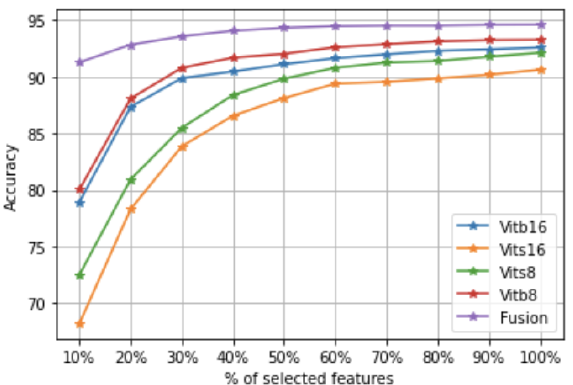
Figure 9. The rate of important feature effects on the classification accuracy of the AID data set with 20% of randomly selected images per class.